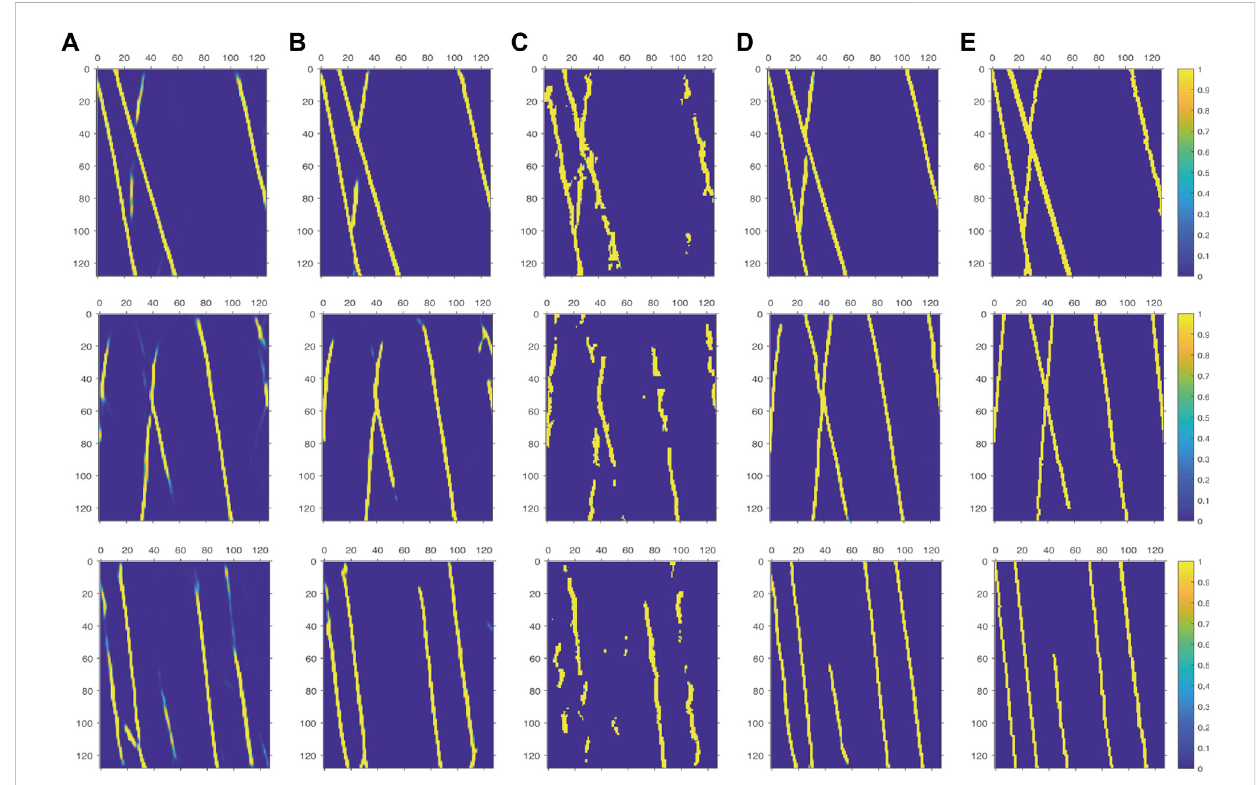
Comparison of predicted faults by using different Unet models in the test data set: (A) standard Unet; (B) TransUnet; (C) Swin TransUnet; (D) our proposed dual Unet with Transformer; (E) ground truth